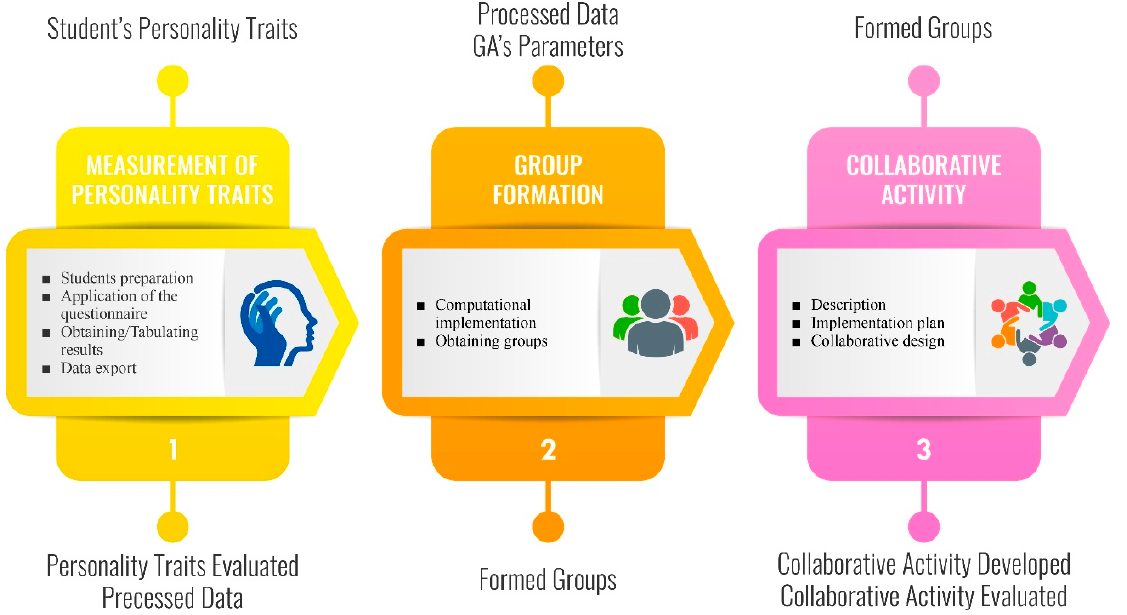
Figure 4. Methodological scheme.